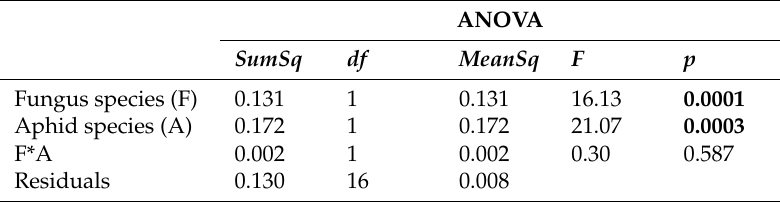
Table 2. Results of ANOVA analysis comparing the total numbers of fungus infections values for each aphid species after infection by P. neoaphidis and E. planchoniana . The interaction between aphid species and fungus species was also analyzed. Abbreviations: df = degree of freedom, SumSq = sum of squares, MeanSq = mean of squares, F = test value, p = significance level. Values in bold indicate significant differences ( p ≤ 0.05). ANOVA SumSq df MeanSq F p 0.131